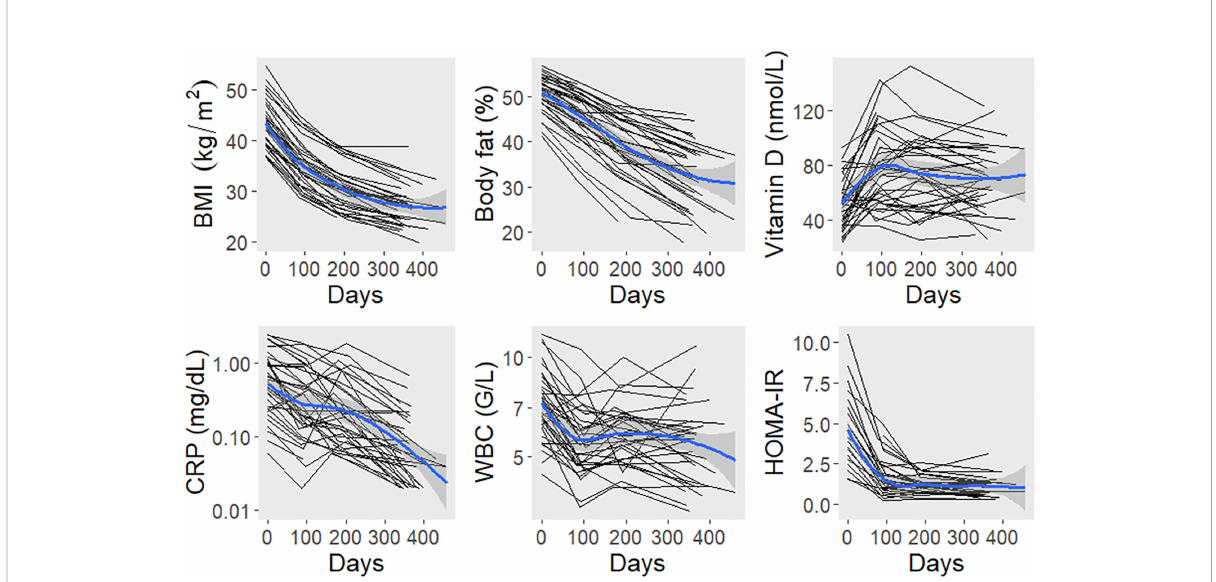
FIGURE 2 Dynamics of anthropomorphic and laboratory parameters after bariatric surgery. The black lines connect values of individual study participants. The blue lines represent locally estimated scatterplot smoothing curves with bands for the 95% con fi dence interval. BMI, body mass index; CRP, C-reactive protein; HOMA-IR, homeostasis model assessment insulin resistance index; WBC, white blood